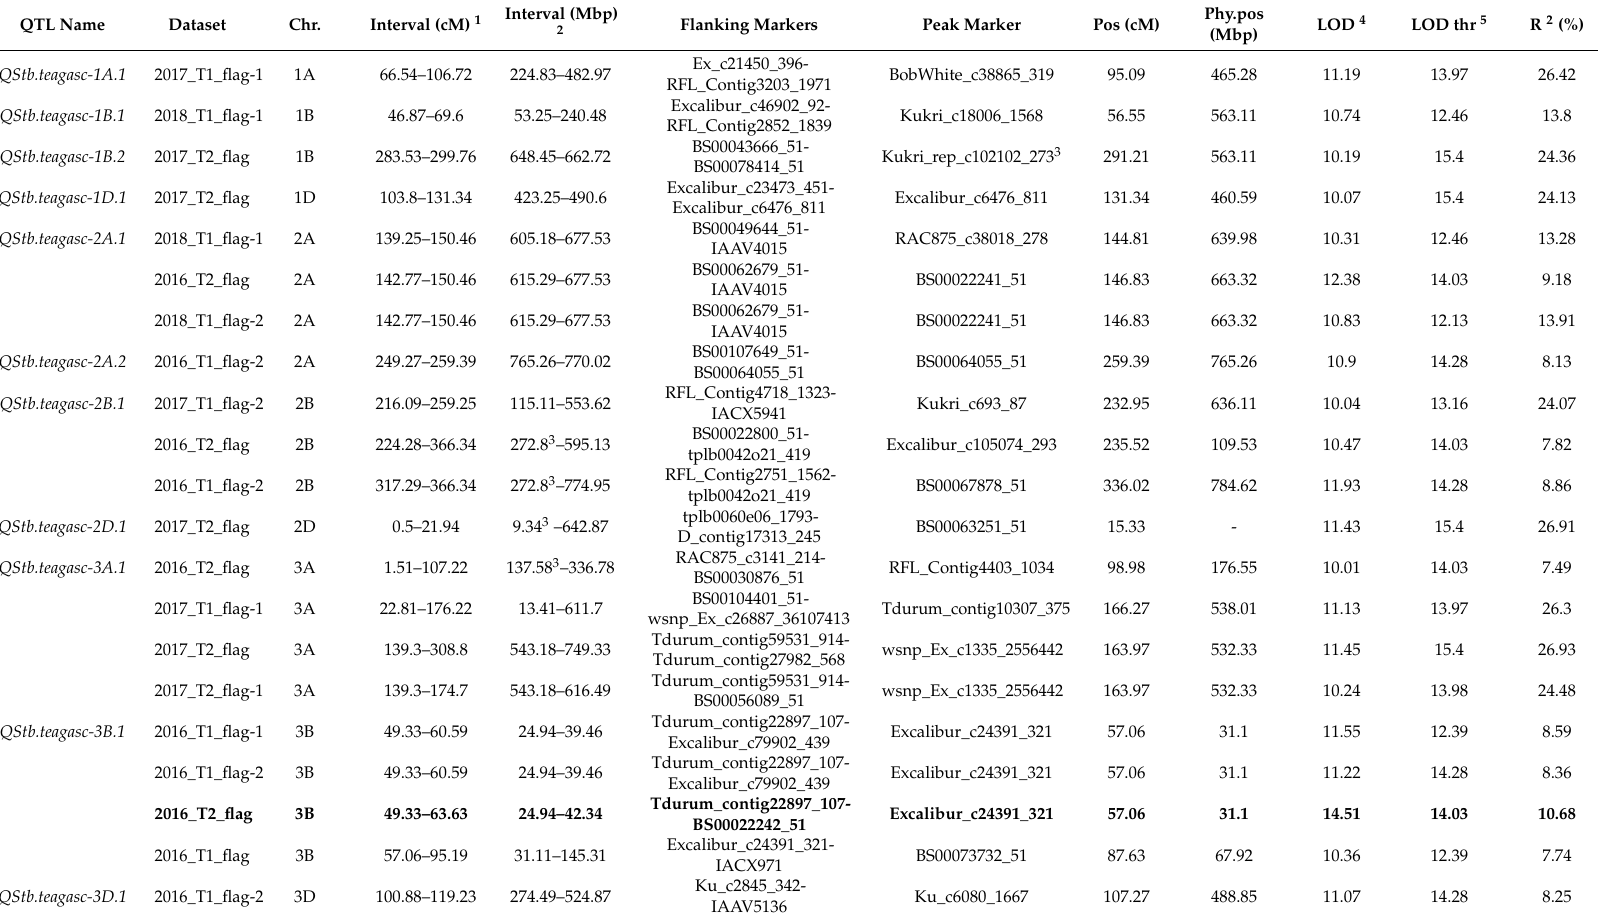
Table 5. Summary of the septoria tritici blotch (STB) resistance QTL identified using Haley-Knott regression method in the MAGIC population grown in the field under natural STB